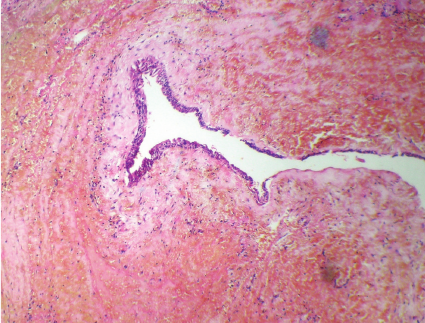
Figure 7: Photomicrograph of nasopalatine duct cyst showing strat- ified squamous